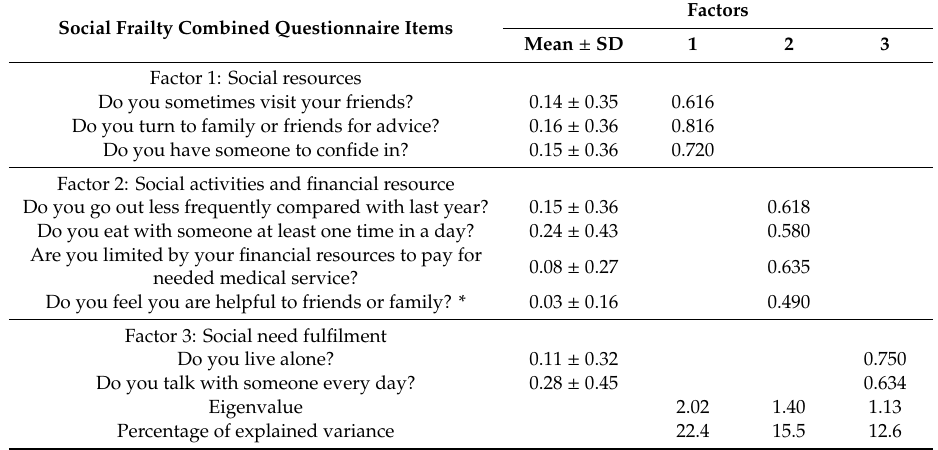
Table 2. Exploratory factor analysis (EFA; varimax rotation, three-factor extraction, loadings >